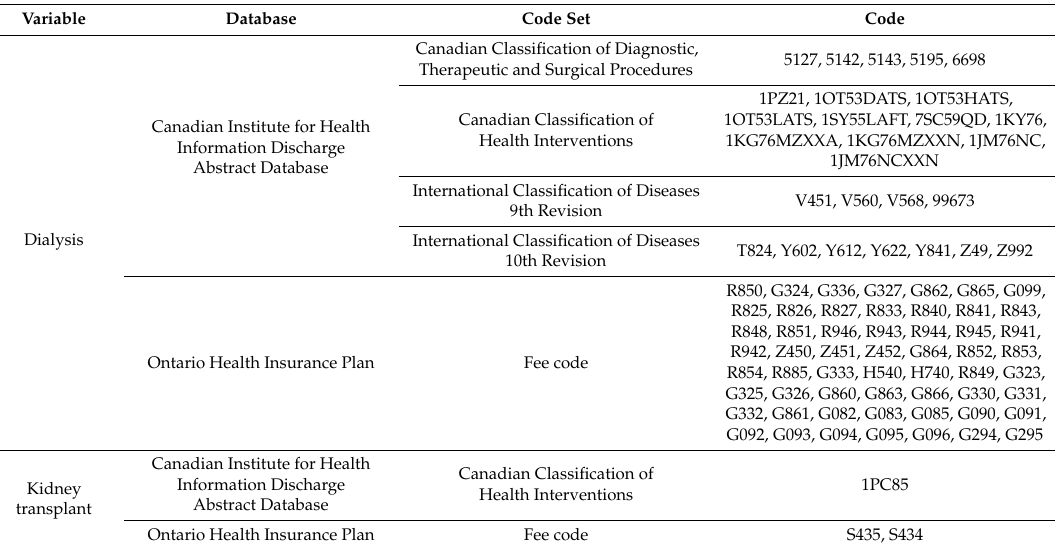
Table A3. Diagnostic codes for exclusion